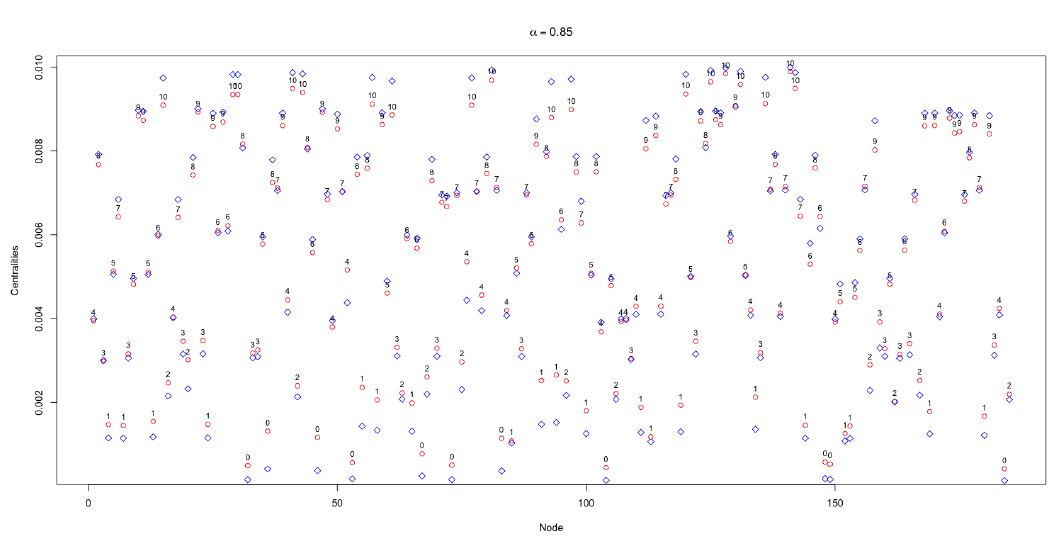
Figure 7. Centralities for the urban network in Figure 6a.